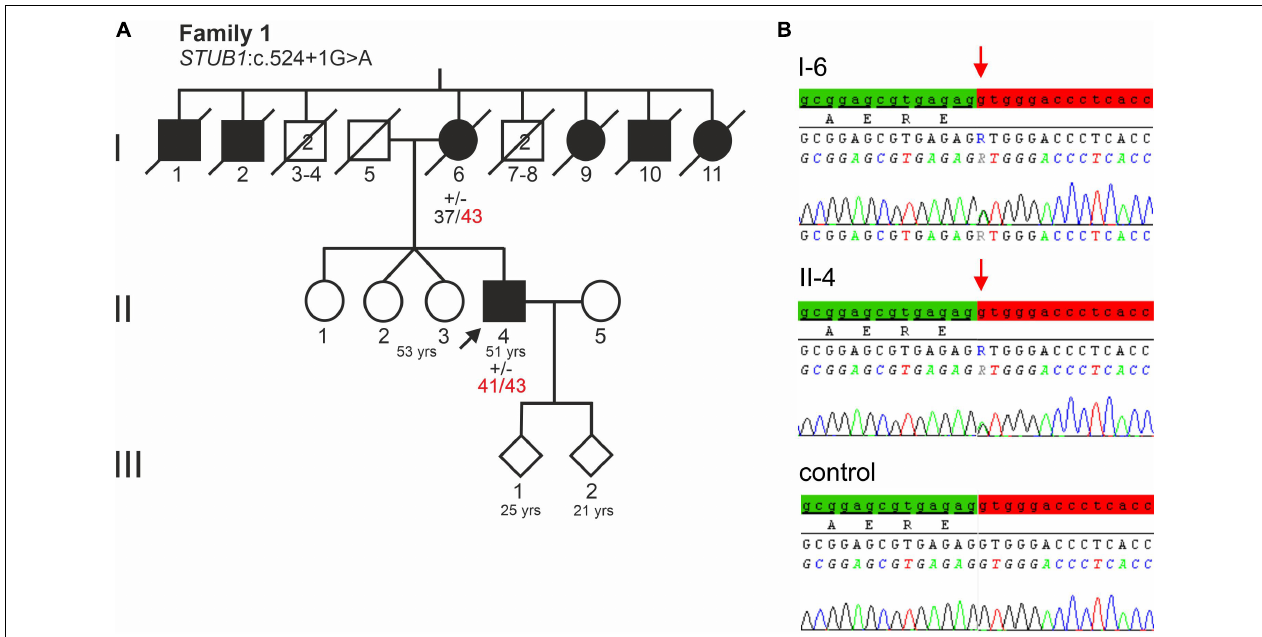
FIGURE 1 | (A) Pedigree of a German family with a severe dementia syndrome. The index patient is indicated by an arrow. Black symbols indicate affected family members. Healthy male relatives of generation I are grouped together, their number is indicated in the symbols. Repeat lengths of the TBP alleles are indicated. ( + / − ) indicates heterozygosity for STUB1 variant c.524+1G > A. (B) Electropherograms of STUB1 sequences of the index patient, his affected mother, and a control. The relevant base change of STUB1 is indicated. Distal exon 3 sequence is highlighted green, while the intronic sequence is highlighted